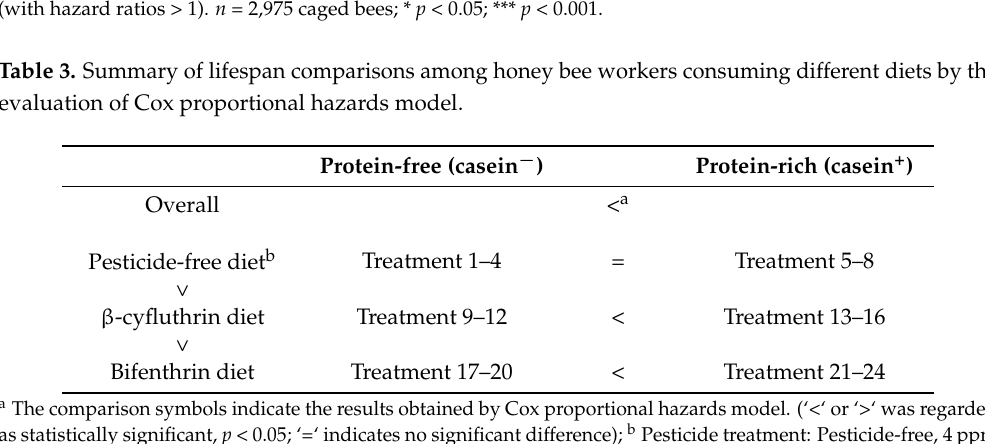
a The comparison symbols indicate the results obtained by Cox proportional hazards model. (‘<‘ or ‘>‘ was regarded as statistically significant, p < 0.05; ‘=‘ indicates no significant difference); b Pesticide treatment: Pesticide-